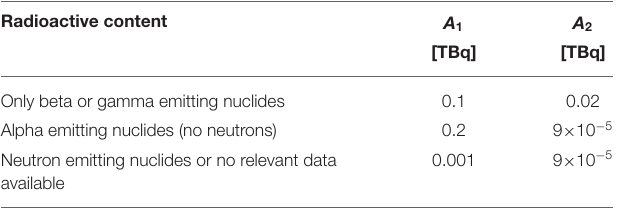
TABLE 1 | Activity limits for unknown radionuclides or